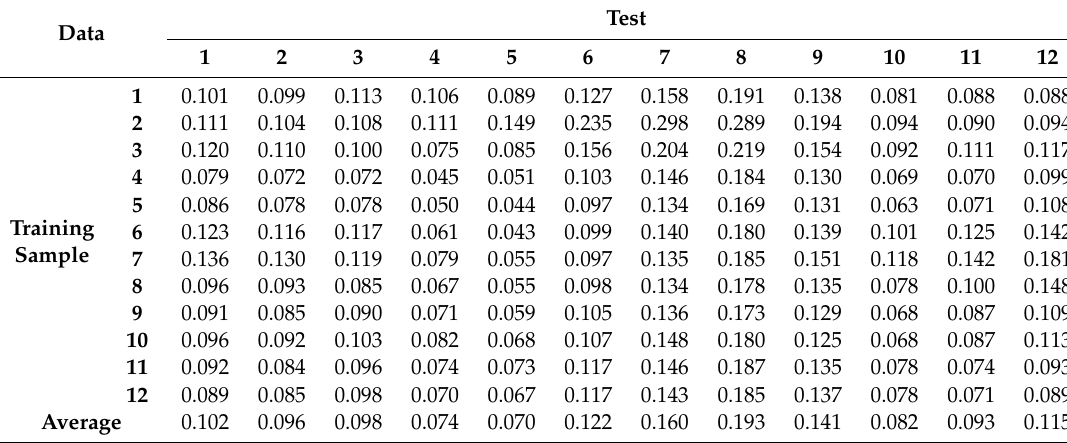
Table 4. Relative error of referred visibility under di ff erent sample conditions with sample data from 2001 to